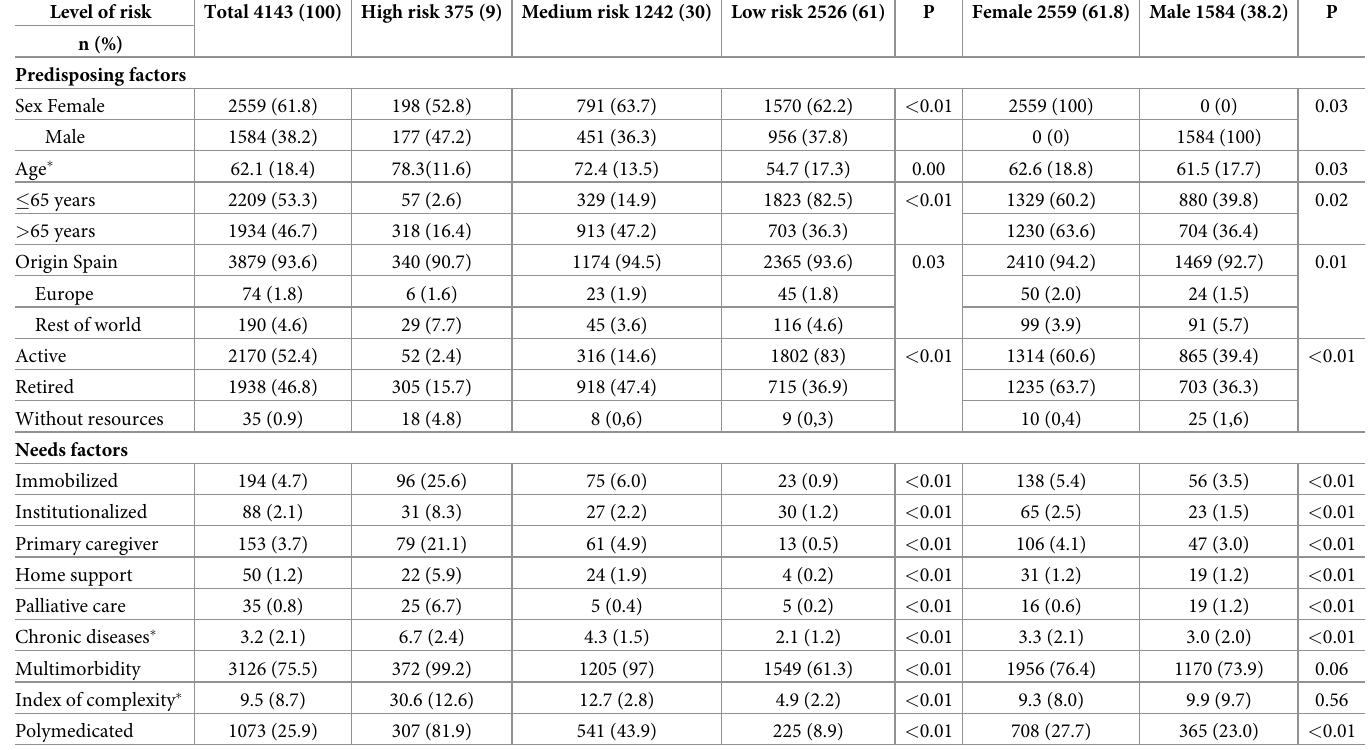
Table 1. Predisposing factors and needs factors of the total chronic patient population stratified by risk level and sex. Level of